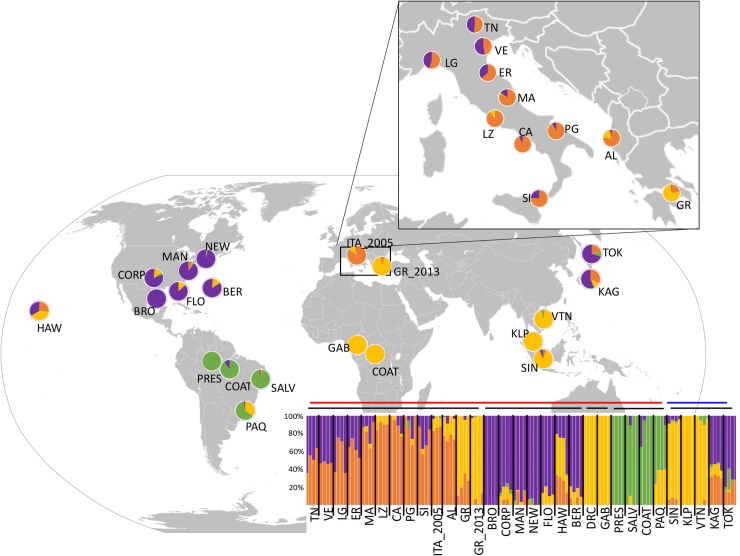
ADMIXTURE results obtained for the global dataset.Map (modified from https://commons.wikimedia.org/wiki/Atlas_of_the_world) shows mean ADMIXTURE Q-values, represented as pie charts for each sampling site, for best the clustering K = 4 for 123 specimens that were part of the LD filtered global dataset (N = 26,094 SNPs). Below the worldwide map the ADMIXTURE barplot obtained for the same set of specimens with individuals represented as vertical bars along the plot grouped by sampling sites (X axis) separated by vertical black bars. The Y axis represents the ancestry (Q value) with different colors representing the four clusters recovered by the analyses. Populations are encoded as in Table 1. Horizontal bars above the barplot indicate invasive (red bar) and native (blue bar) populations as well as to populations from the same continent (black bars). Populations codes as in Table 1.